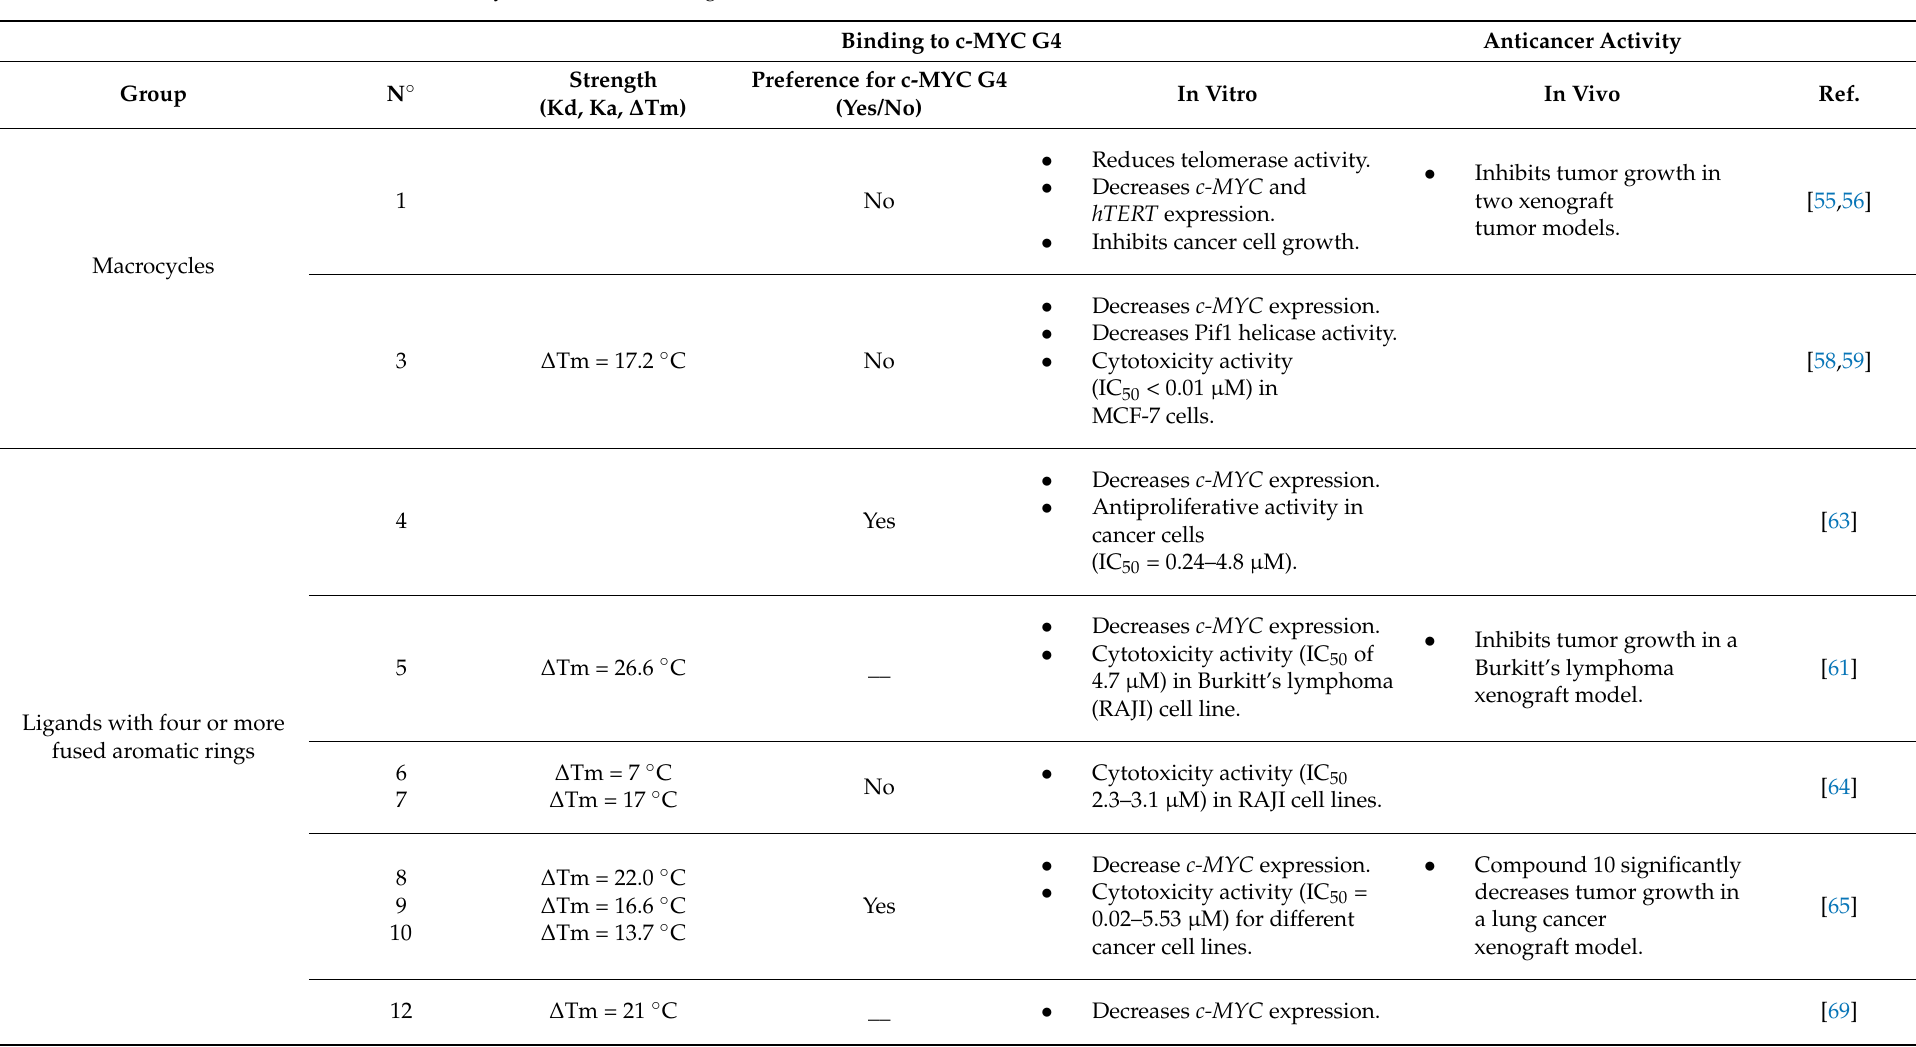
Table 1. Summary of best c-MYC G4 ligands’